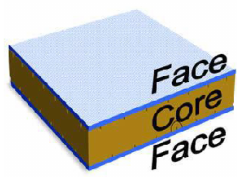
Figure 3: Illustration of the sandwich plate